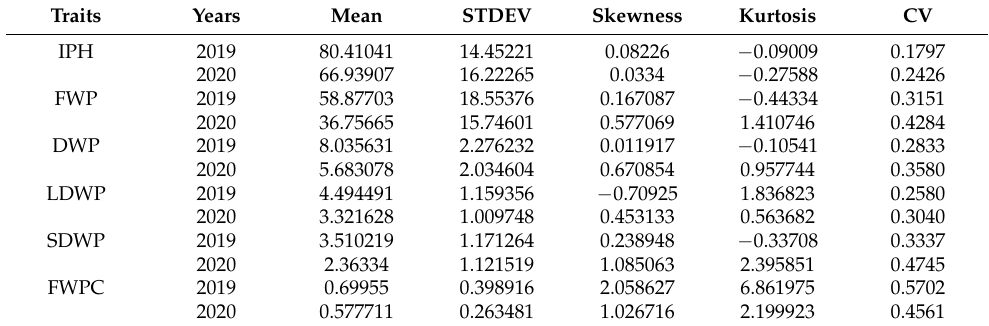
Table 1. Analysis of variation coefficient of forage quality traits in the panel of 301 ramie accessions. Traits